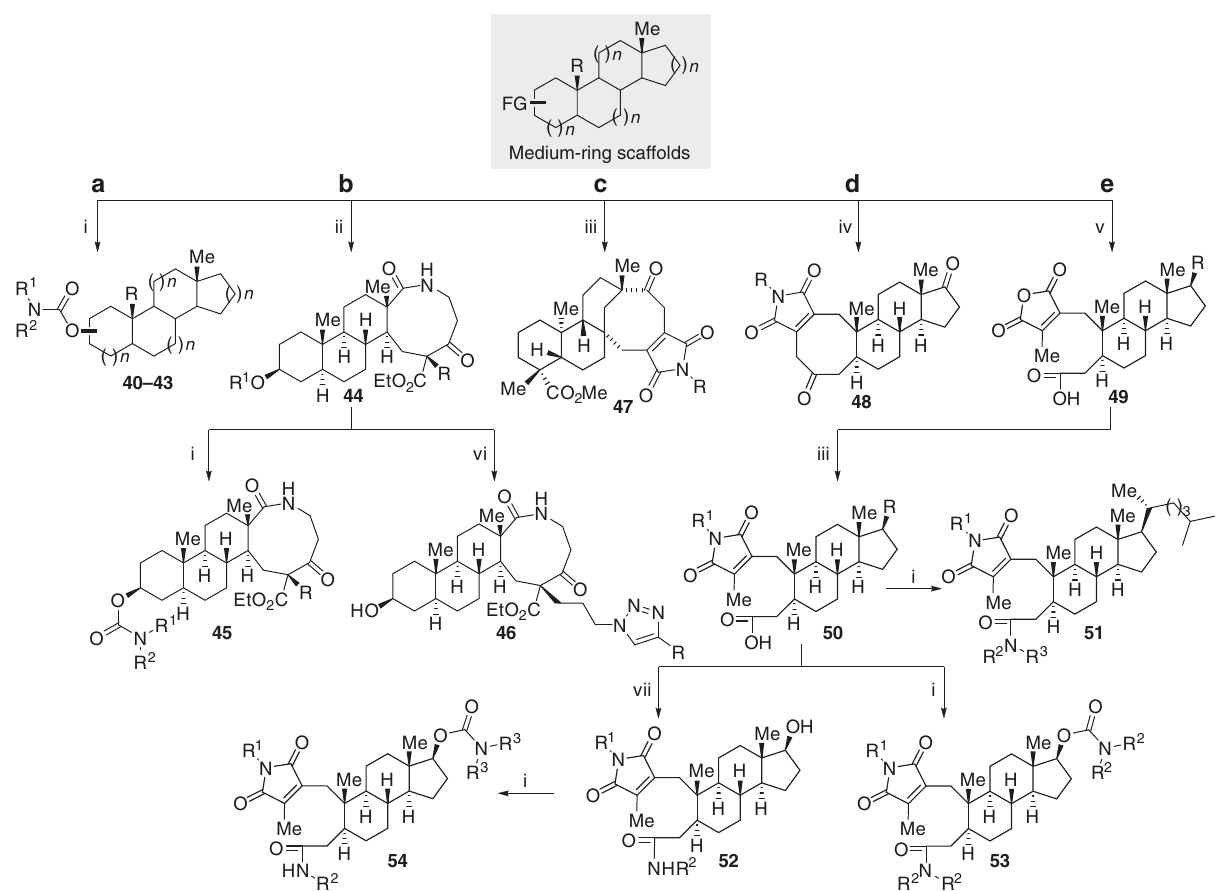
Fig. 5 Further diversication of medium-sized ring scaffolds. a Formation of carbamates. b Formation of azide. c . Formation of imide 47 . d Formation of imide 48 . e Ring-cleavage of medium ring scaffold. A total of 150 polycyclic fi nal products, most of which have >90% purity (LC-MS, ultraviole detector at 254 or 210 nm) and >10 mg quantities, were prepared. (i) (a) CDI, Et 3 N, CH 2 Cl 2 , rt, (b) R 1 R 2 NH, DMAP, toluene, 90 °C; (ii) NaH, HMPA, THF, then RI, rt; (iii) R 1 R 2 NH, toluene/CH 2 Cl 2 , rt, then 90 °C; (iv) (a) 5 M NaOH, THF, 60 °C, then NaBH 4 , rt, then HCl, (b) RNH 2 , toluene, rt, then 90 °C, (c) Dess-Martin oxidant, NaHCO 3 , CH 2 Cl 2 ; (v) (a) NaOH, EtOH/H 2 O, 100 °C, (b) DMSO, HCl, 120 °C; (vi) (a) NaN 3 , DMF, 80 °C, (b) Sodium ascorbate, CuSO 5 (cid:129) H 2 O, HCCR, THF/H 2 O, rt, (c) TsOH, THF/H 2 O, rt; (vii) DPPA, Et 3 N, R 2 NH 2 , DMF, rt. Full details are in the Supplementary Figures 13 –